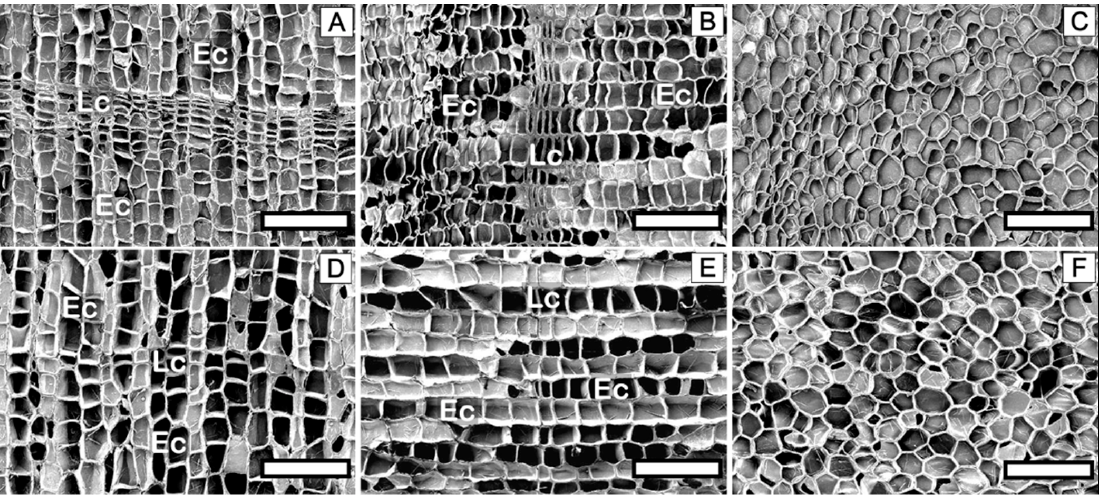
Figure 5. Transverse ( A , D ), radial ( B , E ), and tangential ( C , F ) sections of Q. variabilis virgin cork ( A – C ) and Q. suber reproduction cork ( D – F ). Earlycork (Ec) and latecork (Lc). White scale bar represents 100 μ m.